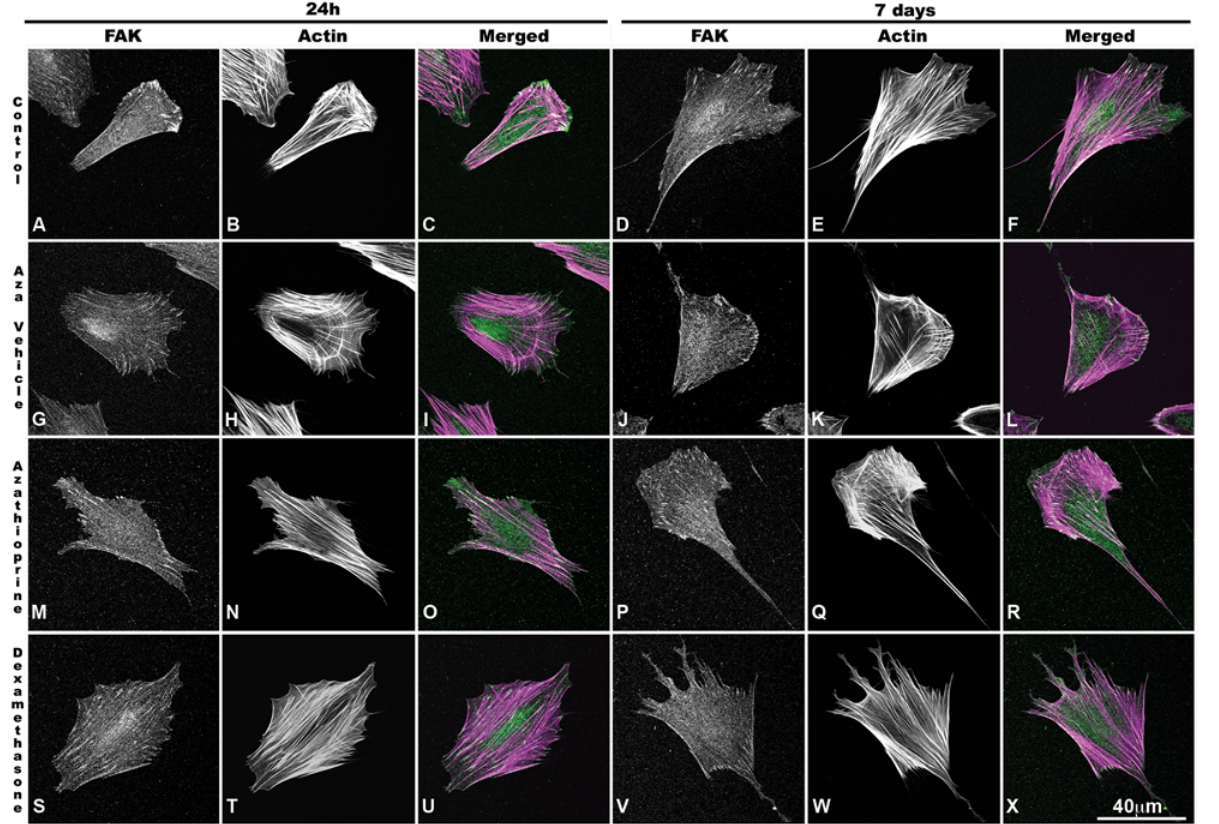
Fig 5. Actin cytoskeleton and FAK distribution. MSCs were cultured for 24 h or 7 d with or without drugs, plated on fibronectin-coated dishes overnight, fixed and stained for focal adhesion kinase (FAK) and actin analysis. FAK (green) and actin (magenta) co-localization (white) is demonstrated on merged images. Control cells showed small adhesions at the cell border (A and D) and actin stress fibers (B and E) that showed no variation in the presence of AZA vehicle for 24 h (G-I) or 7 days (J-L) . Cells treated with AZA (1 μ M) presented large adhesions at the cell rear and smaller adhesions at the cell cortex (M and P), the presence of ventral stress fibers (N) and a tendency of increased presence of dorsal stress fibers (Q) . After 24 h or 7 days of DEX treatment, there was an increase in adhesion size throughout the cell body (S and V) and ventral stress fibers (T, W) , which was followed by an increase in instable membrane projections at 7 days (X) . Bar = 40 μ m; representative images of n = 40 cells per condition.